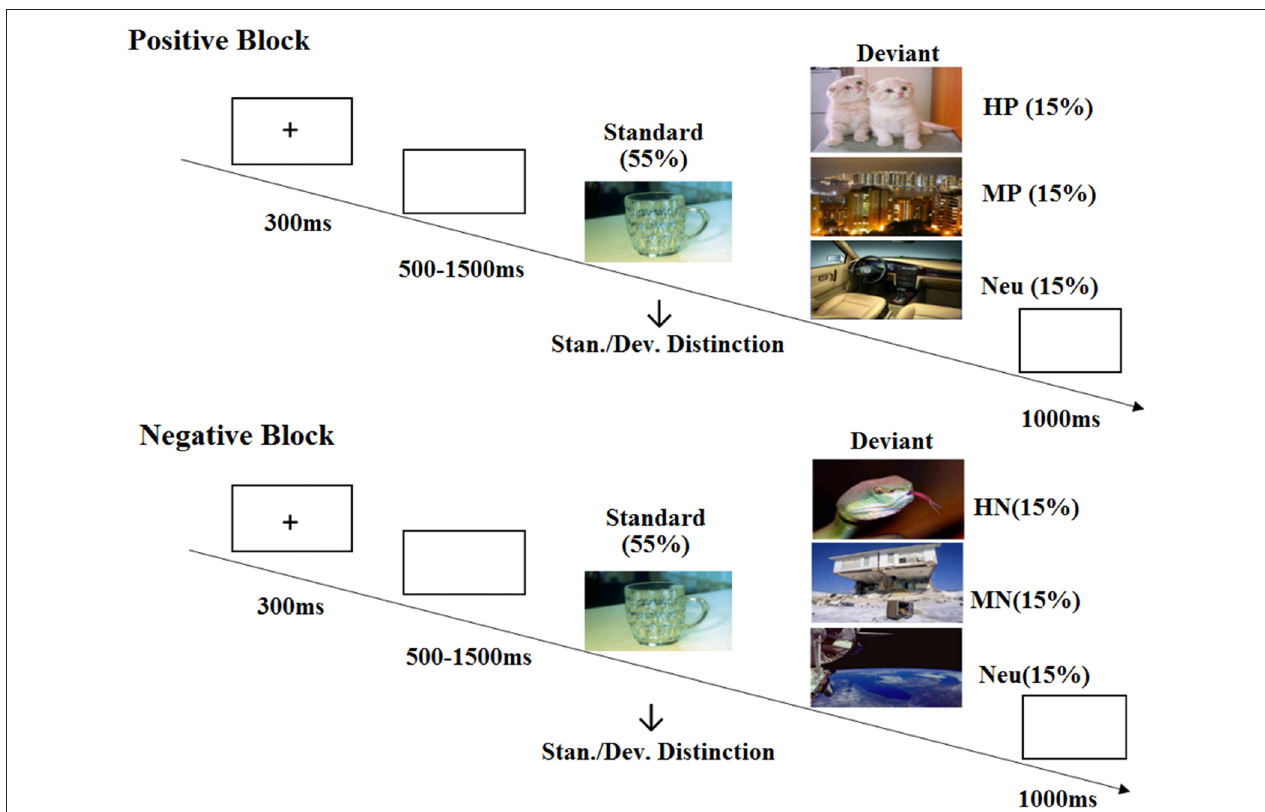
FIGURE 2 | Schematic illustration of the experimental procedure and the stimulus